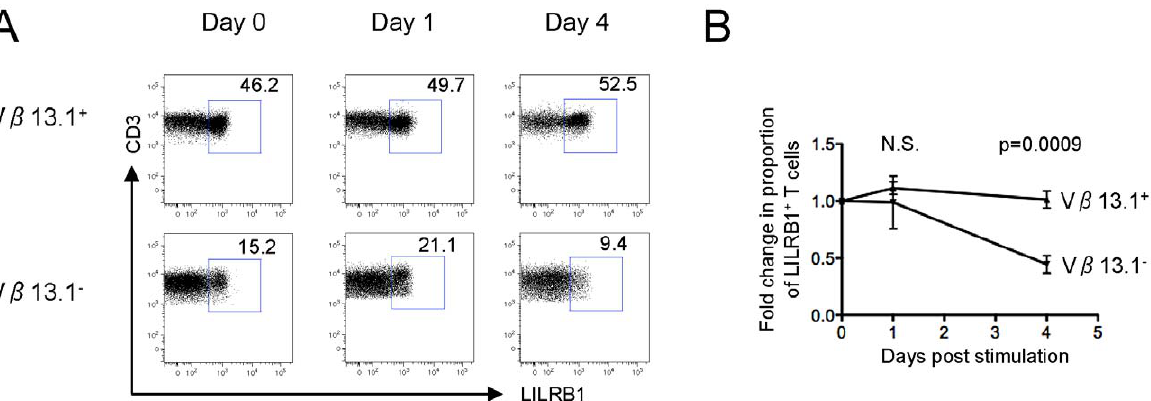
Figure 5. Stable LILRB1 expression on T cells after ‘‘bystander activation’’. (A) Representative dot plots demonstrating proportions of LILRB1-expressing V b 13.1 + and V b 13.1 2 T cells after activation with SEB over indicated time course. (B): Fold change of LILRB1 expression on V b 13.1 + or V b 13.1 2 T cells at indicated time points. Mean and standard error from 7 different HIV-1 negative donors are shown. Significance was tested by paired T